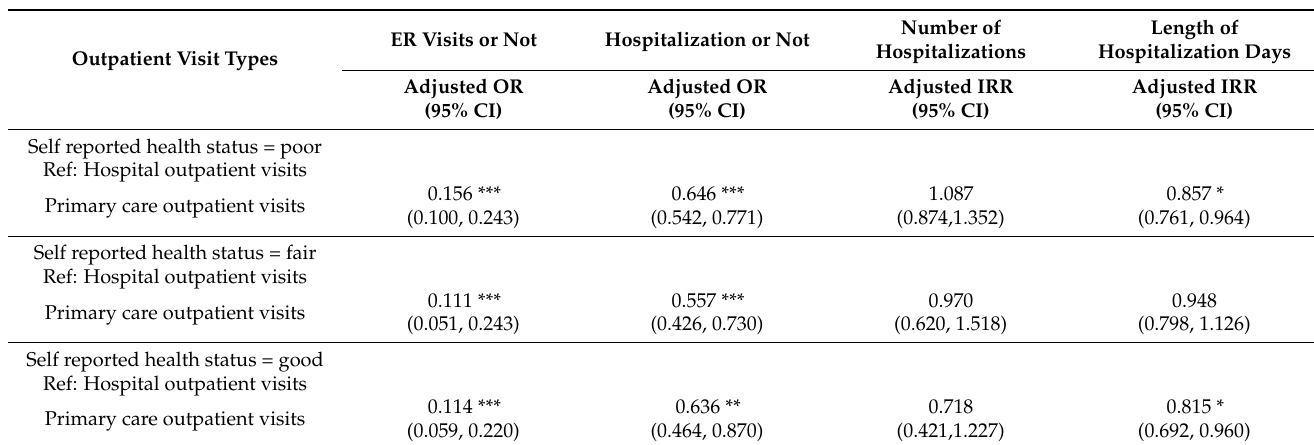
Table A2. Association between outpatient visit types and ER or hospital inpatient services utilization, stratified by self-reported health